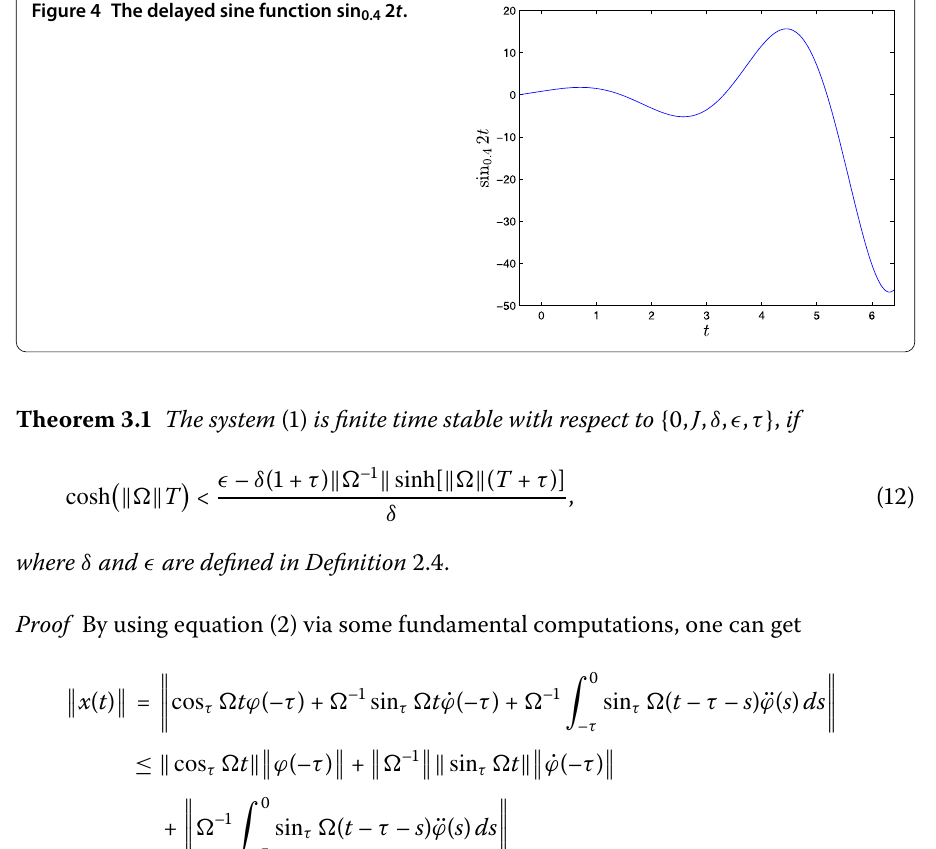
Figure 4 The delayed sine function sin 0.4 2 t